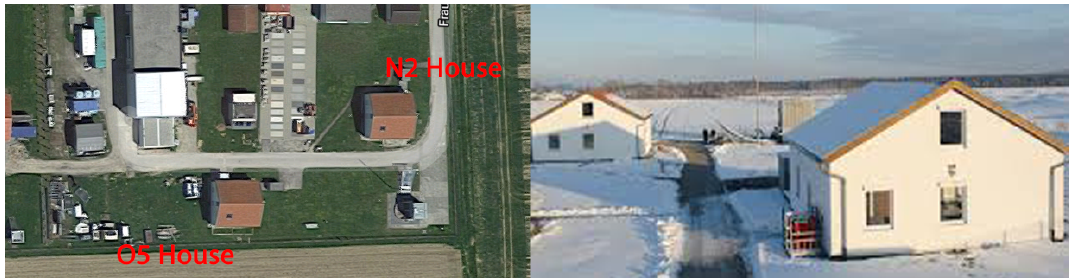
Figure 1. External views of twin Houses (N2 and O5). Holzkirchen, Germany.